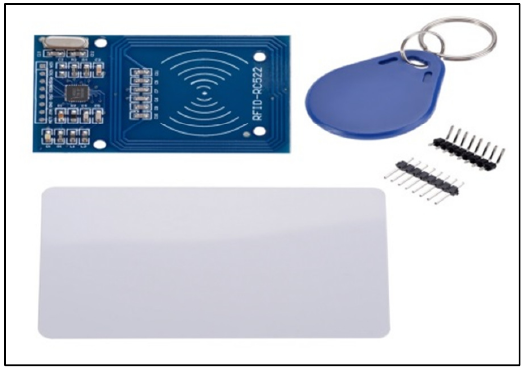
Fig. 2. RFID sensor component (tags and reader).